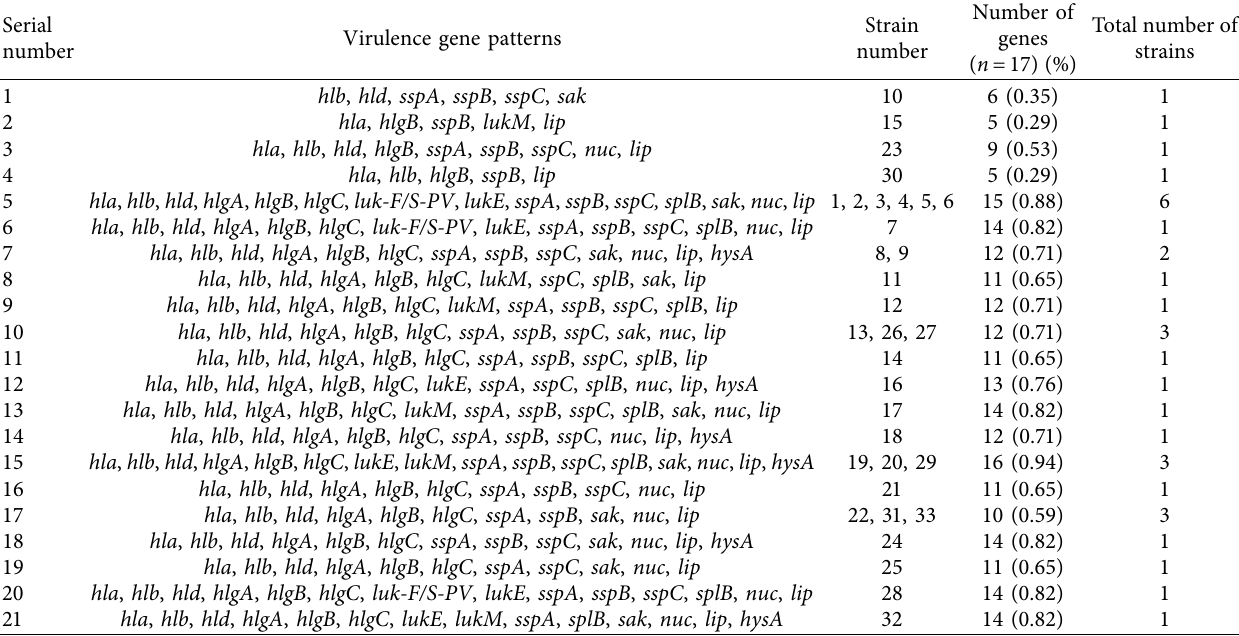
Table 4: Virulence gene patterns of 33 S. aureus